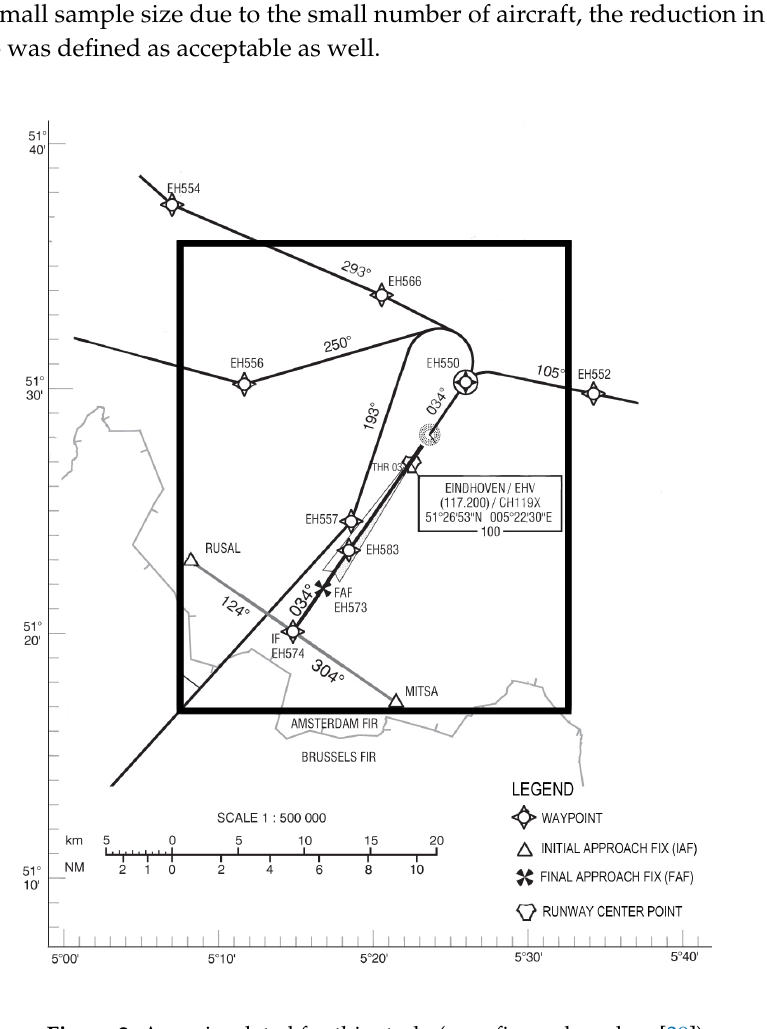
Figure 2. Area simulated for this study (own figure, based on